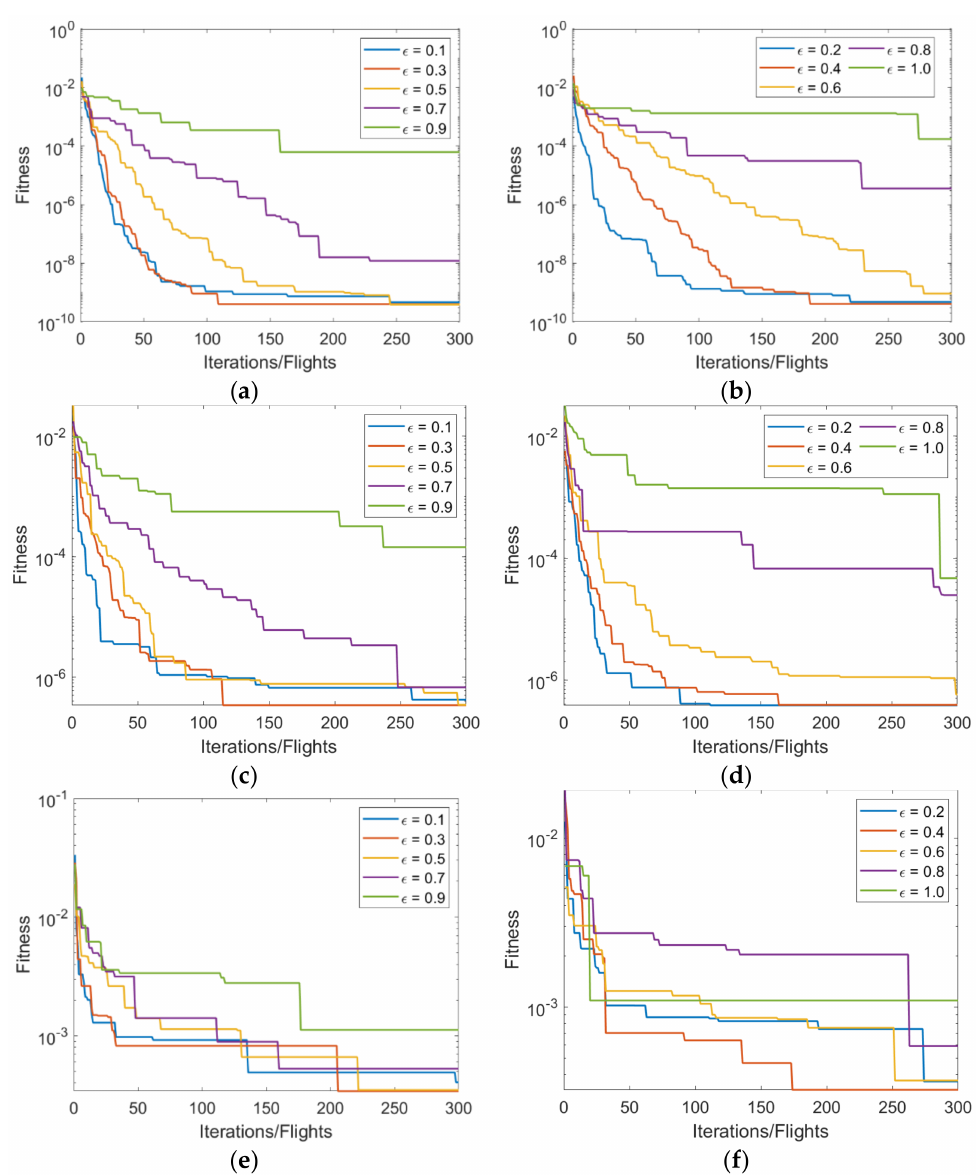
Figure 3. Plots of convergence curves for different fractional orders ε and noise levels η . ( a ) odd ε and η = 90 ( b ) even ε and η = 90 ( c ) odd ε and η = 60 ( d ) even ε and η = 60 ( e ) odd ε and η = 30 ( f ) even ε and η =